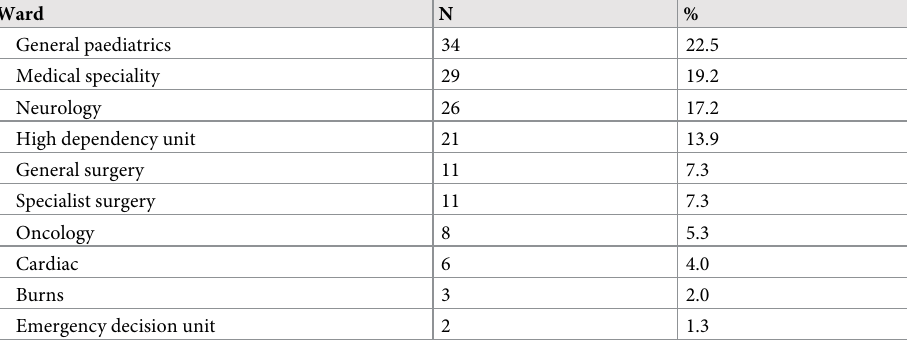
Table 3. Ward/unit professionals working on.